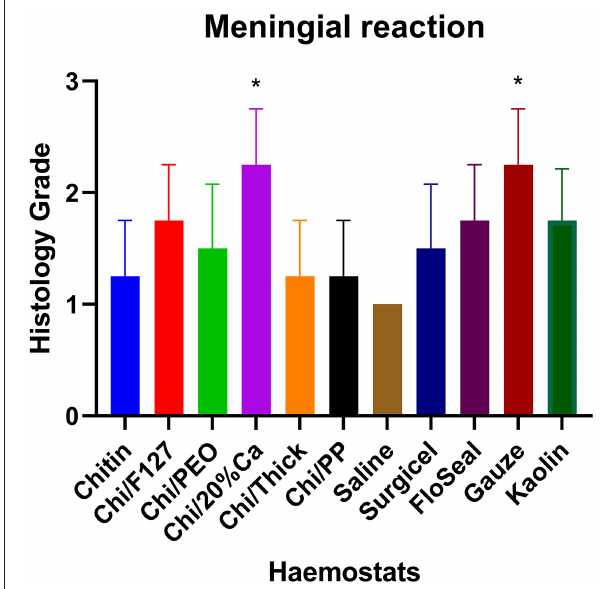
FIGURE 8 | Meningeal mononuclear cell reaction with the application of modified and non-modified beta-chitin patches, Surgicel, FloSeal, Gauze and Kaolin (positive control) to rat brain. * p < 0.05 and compared to non-modified beta-chitin patch, analyzed by Kruskal-Wallis one-way ANOVA with Dunn’s test, n =